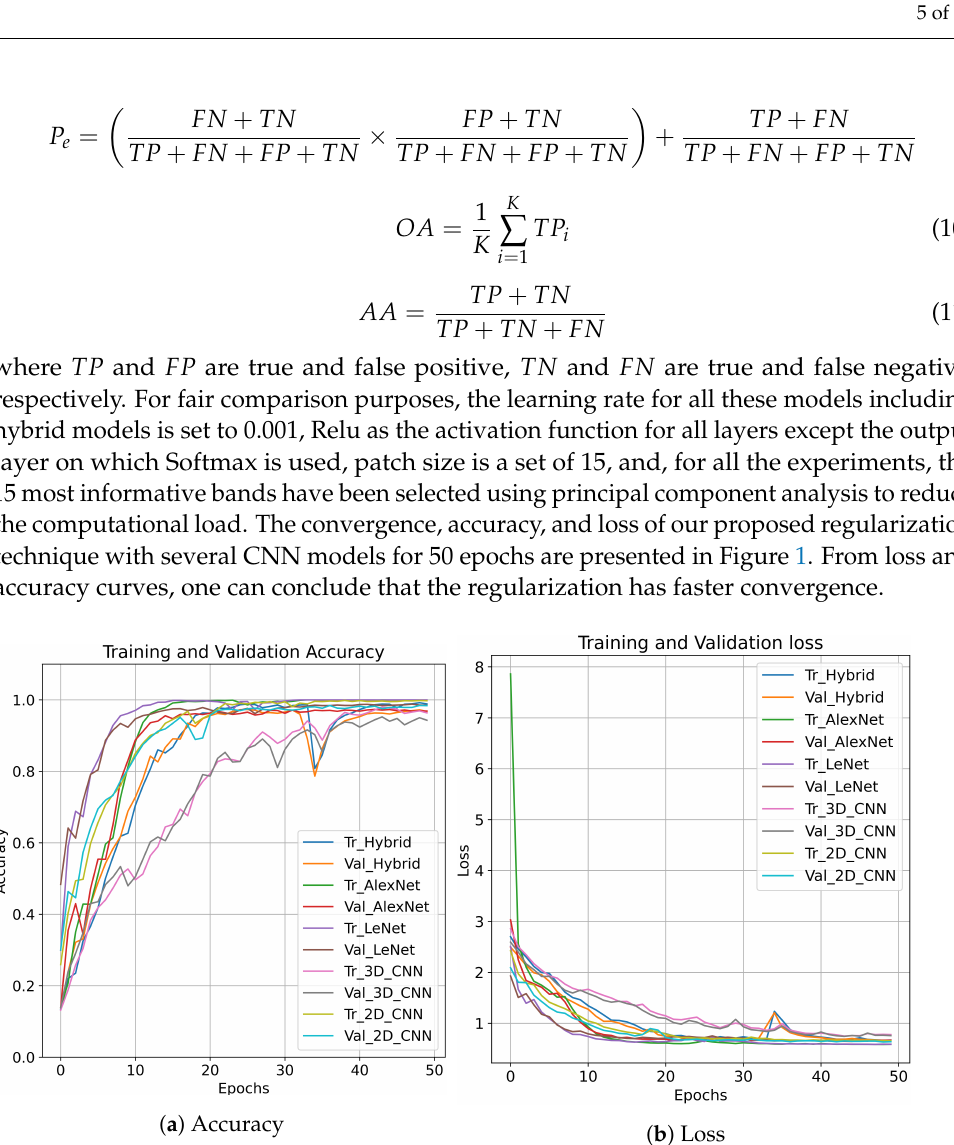
Figure 1. Accuracy and loss for training and validation sets on Indian Pines for 50 epochs.